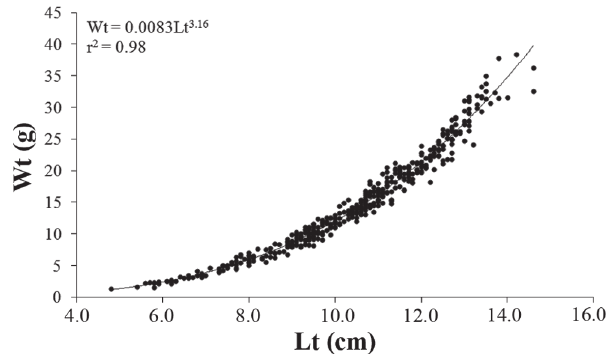
Fig. 4. Weight-length relationship for grouped sexes of Etropus crossotus in the shallow infralittoral areas of the Paranaguá Estuarine Complex. Total amostral N = 395, female amostral N = 171, and male amostral N =224.